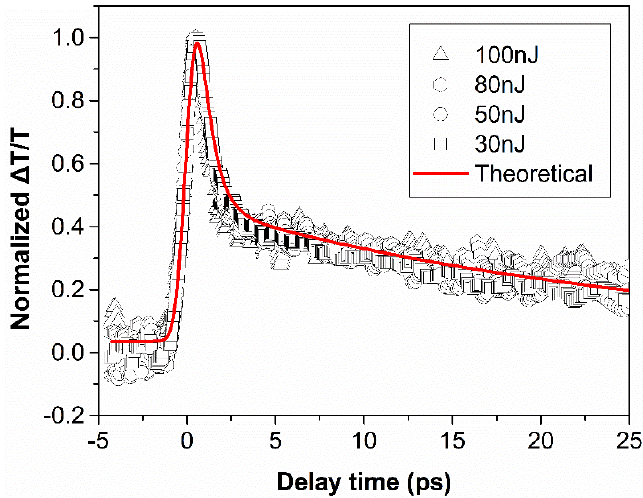
Figure 6. Normalized transient differential transmission at the different pump energies of 30, 50, 80, and 100 nJ.